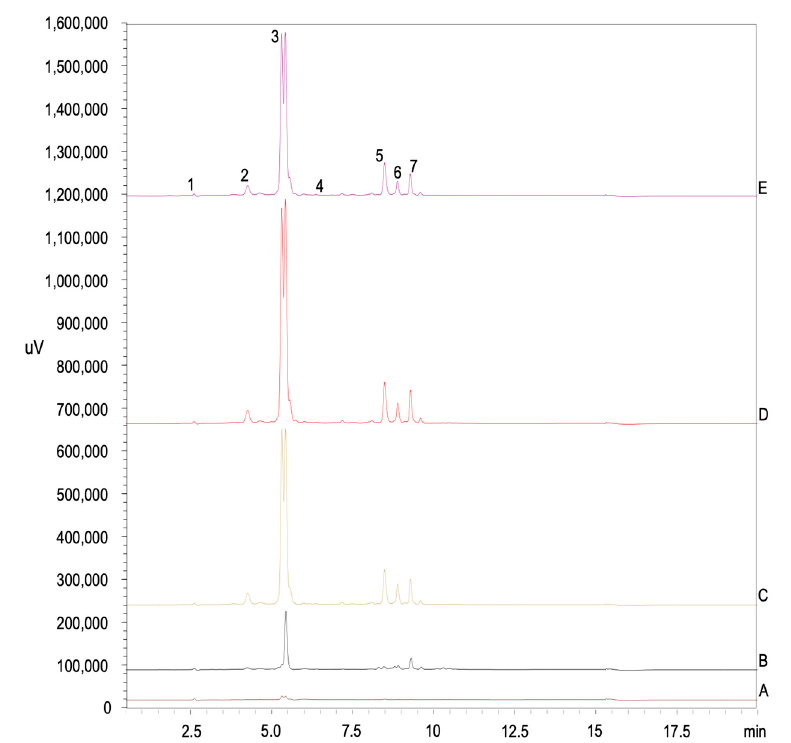
Figure 3. U-HPLC chromatograms (shown at 476 nm) of identified carotenoids from methanol/MTBE (60:40, v / v ) extracts of carrot seed ( A ) and carrot sprouts on 7 days in darkness+3 days of a light/darkness photoperiod under several light treatments at 20 °C: Darkness ( B ), Fluorescent ( C ), Blue+Red LEDs ( D ), and Blue+Red+Far-Red LEDs ( E ). Identified peaks are: All-trans neoxanthin (1), 13-cis or 13 ′ -cis lutein (2), All-trans lutein (3), 9-cis or 9 ′ -cis lutein (4), 15-cis β -carotene (5), All-trans β -carotene (6), and 9-cis β -carotene (7).